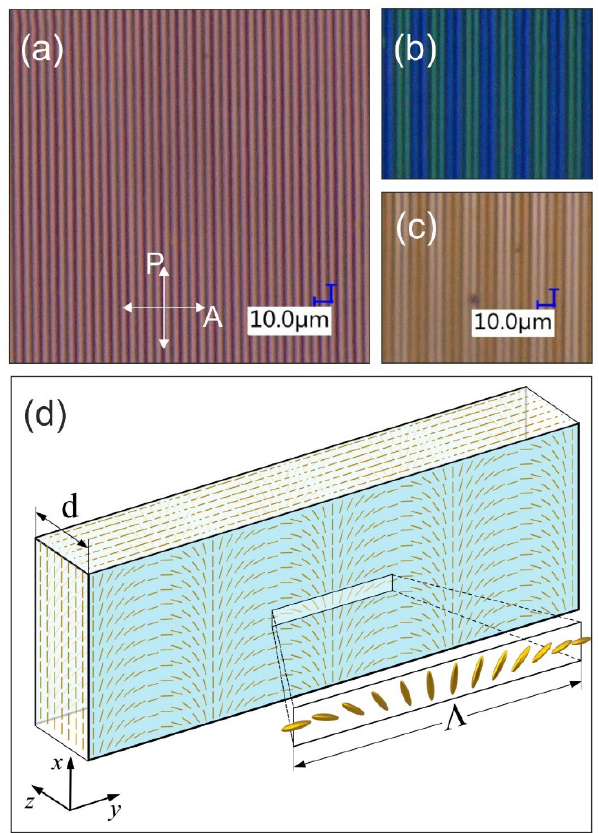
Figure 2. Optical microscope image of the LC_1 cell placed between the crossed polarizers ( a ) at 0 V, ( b ) at 1.35 V, ( c ) at 2.2 V; ( d ) schematic drawing of the expected LC director orientation in the bulk of the cell at 0 V.